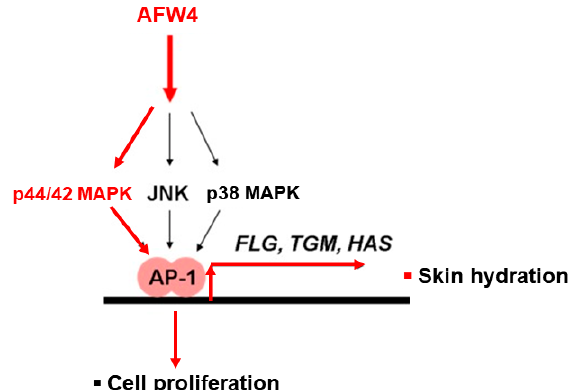
Figure 8. Mechanisms of cell-proliferating and skin-hydrating activities of AFW4. AFW4 promoted cell proliferation and upregulated expression of skin hydrating genes in HaCaT cells. The effects of AFW4 on cell proliferation and skin hydration are mediated by activating p44/42 MAPK. Red arrow: Activation pathway by AFW4.